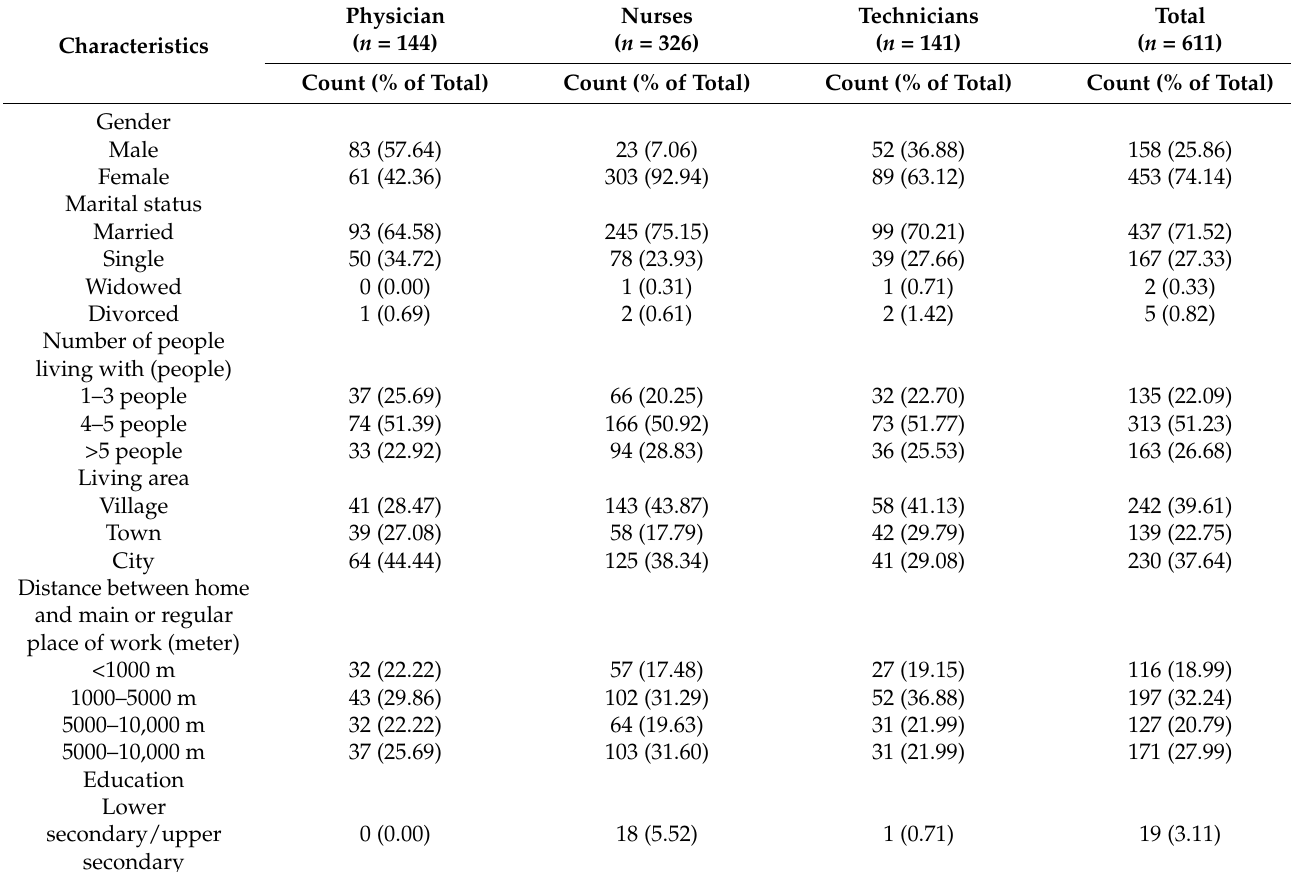
Table 1. Socioeconomic and COVID-19 control-related characteristics of the